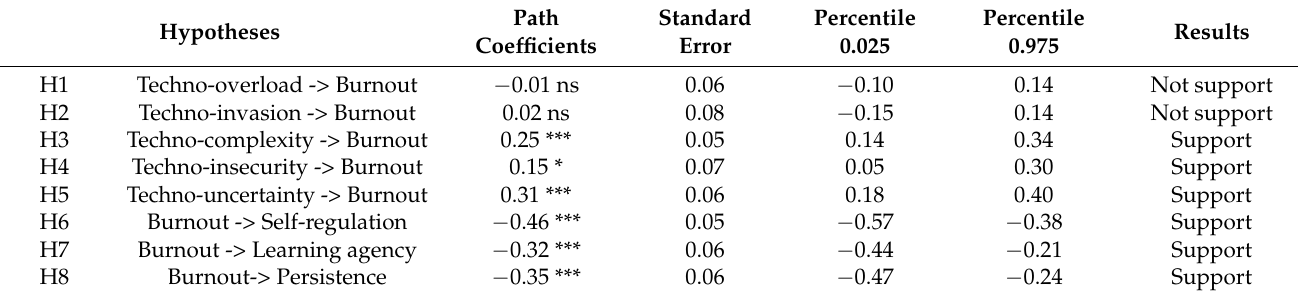
Table 3. Bootstrap validated outcomes of the SSO